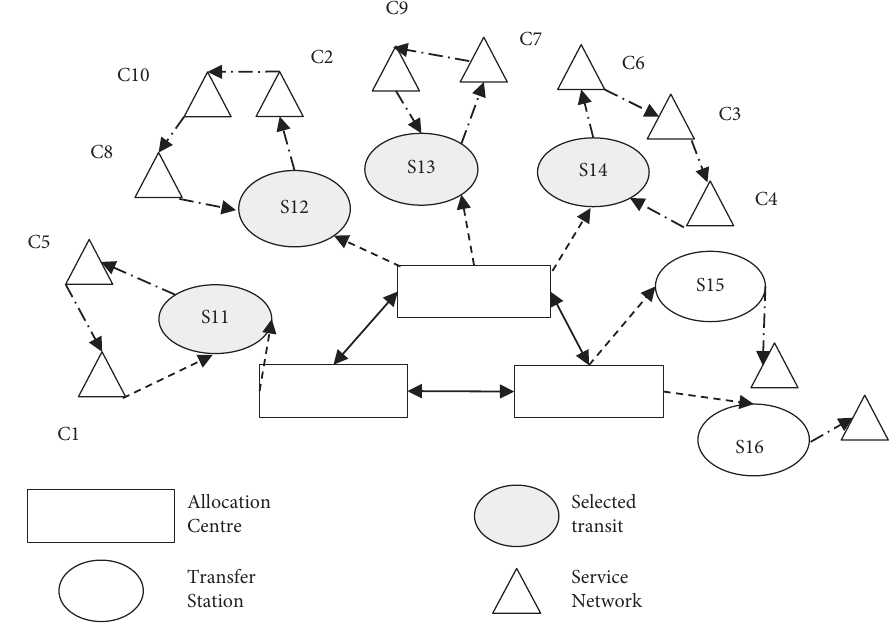
Figure 4: Single-level e-commerce logistics network model